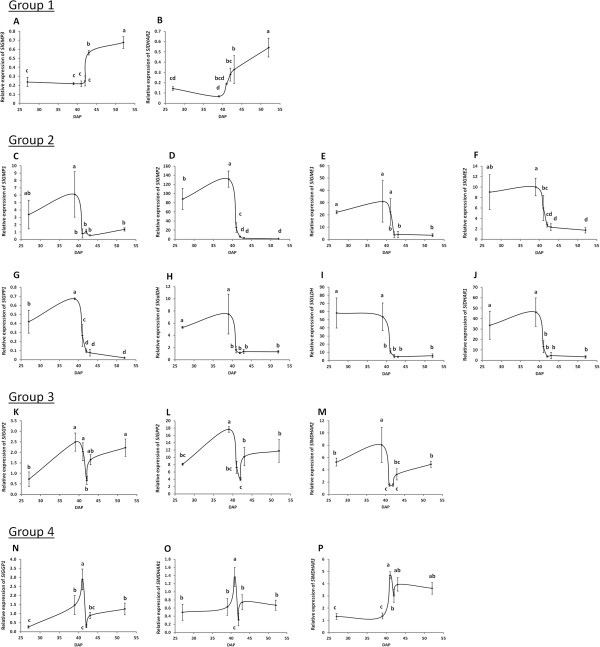
Gene expression studies. Changes in the relative expression of genes involved in L-ascorbic acid (AsA) metabolism of ‘Ailsa Craig’ fruits at immature green (IG; 27DAP), mature green (MG; 39DAP), B-1 (41DAP), breaker (B; 42DAP), B + 1 (43DAP), and red (52DAP) stage. Ripening stages are expressed as Days After Pollination (DAP). qPCR values were normalized against the geometrical mean of the expression of CAC and PP2Acs. Results are presented as the mean of three biological (each of them consist of a pool of 3 samples of equivalent stage) and two technical replications ± SD. Genes have been divided into four groups based on their relative expression pattern during ripening: 1) increase with ripening (A, SlGMP3; B, SlDHAR2), 2) decrease with ripening (C, SlGMP1; D, SlGMP2; E, SlGME1; F, SlGME2; G, SlGPP1; H, SlGalDH; I, SlGLDH; J, SlDHAR1), 3) peak at MG stage (K, SlGGP2; L, SlGPP2; M, SlMDHAR2) and 4) peak at B-1 stage (N, SlGGP1; O, SlMDHAR1; P, SlMDHAR3). Different letters indicate significant differences (P < 0.05) between values based on Duncan's multiple-range-test in SAS.